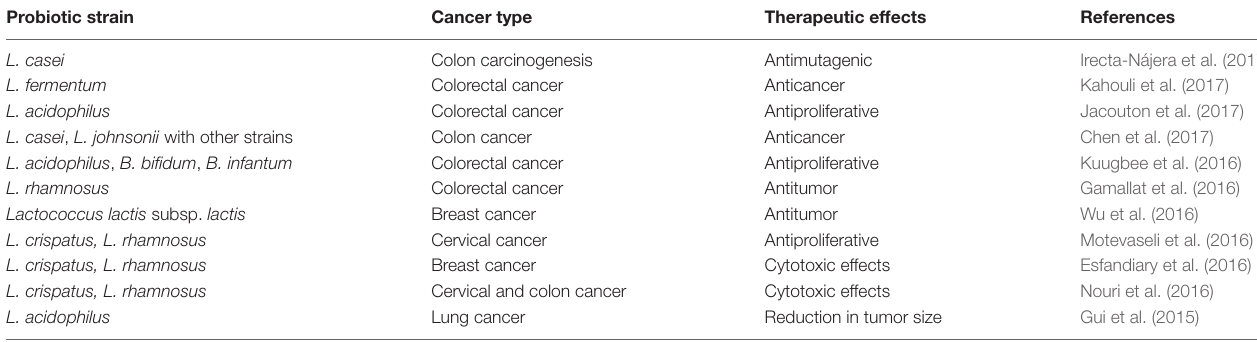
TABLE 3 | In vitro and in vivo effect of probiotics against